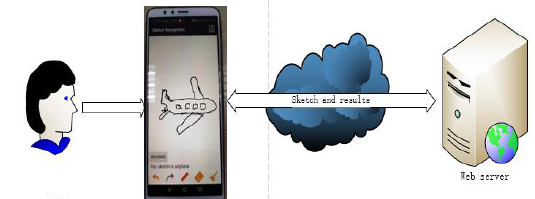
Figure 3. Illustration of traditional sketch recognition system